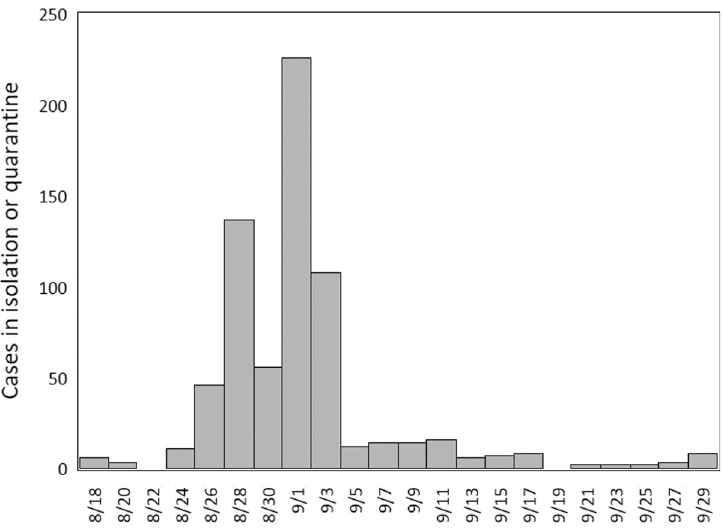
Fig 1. Histogram of COVID-19 cases of exposure requiring quarantine or isolation at the start of the 2020 academic year. Each date represents the inclusive end date of a two-day interval.